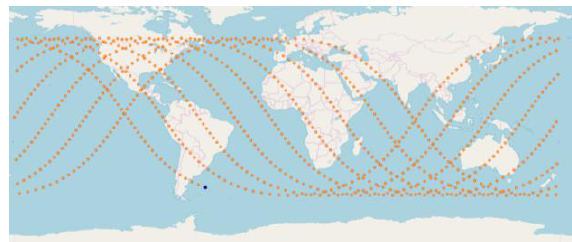
Figure 3: Simulated satellite trajectory for ISS. The comparison of this could be made with Figure 2.